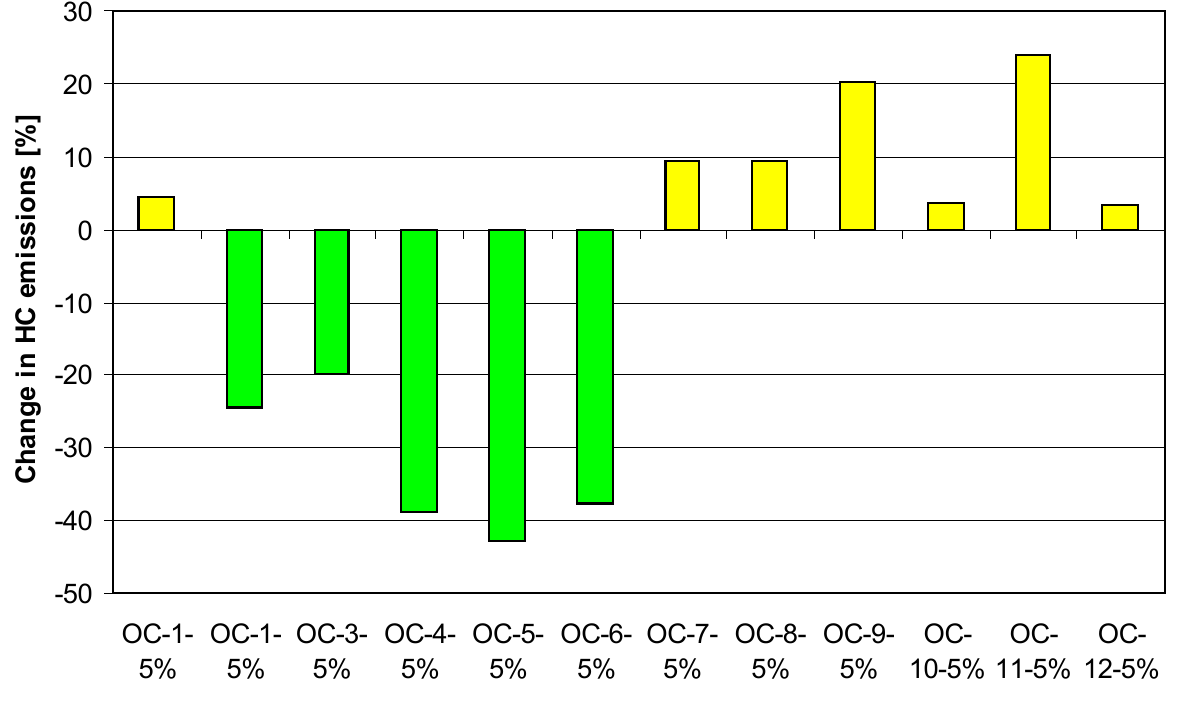
Figure A3. Percentage changes in CO emissions over the NEDC from a test car with fuels containing individual oxygenates at a concentration of 5% v/v compared to running on conventional diesel fuel.